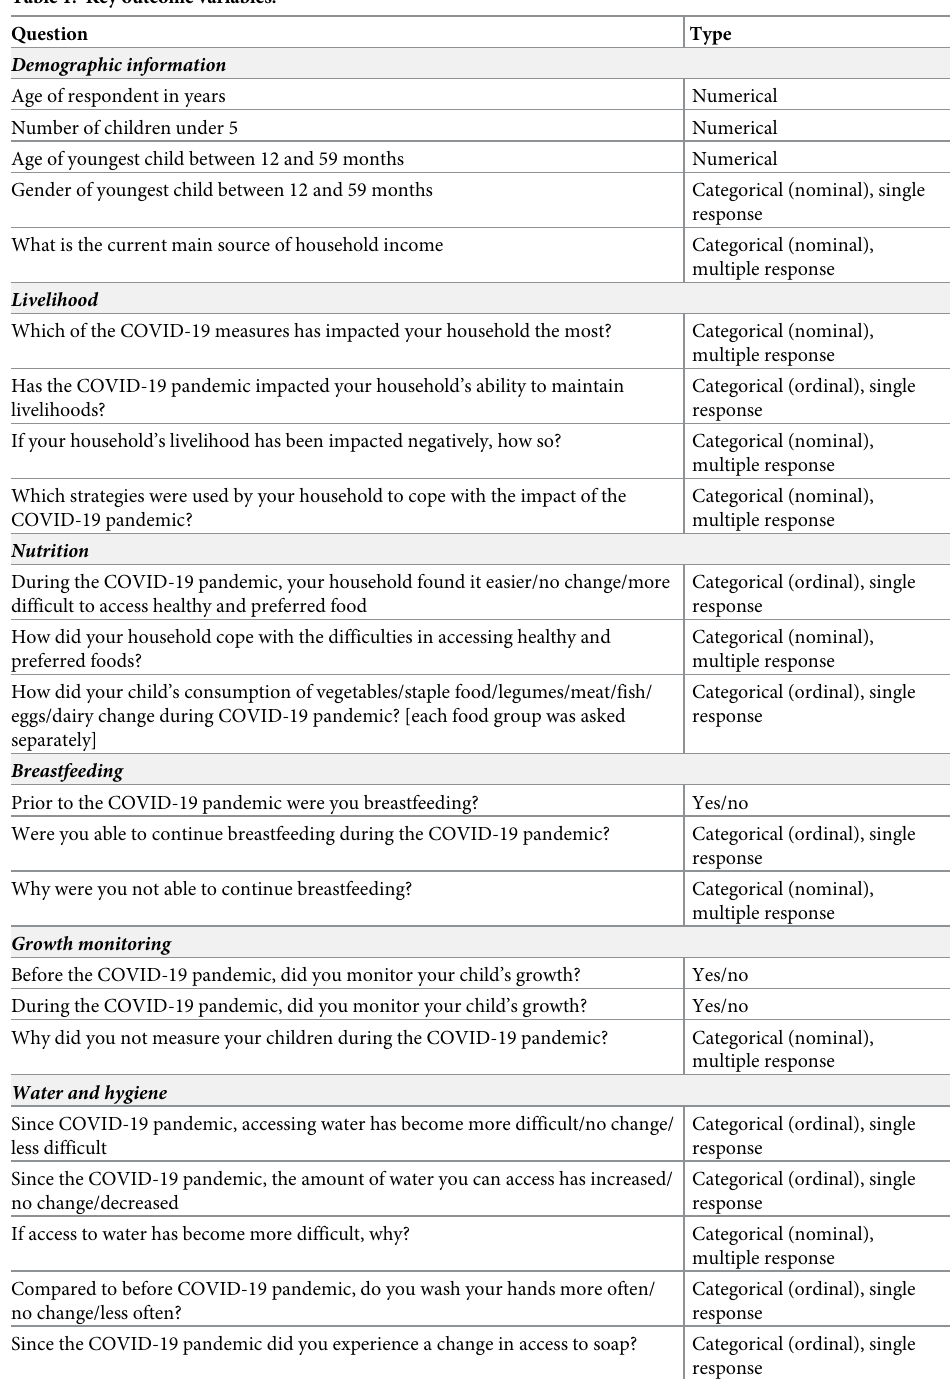
Table 1. Key outcome variables. Question Type Demographic